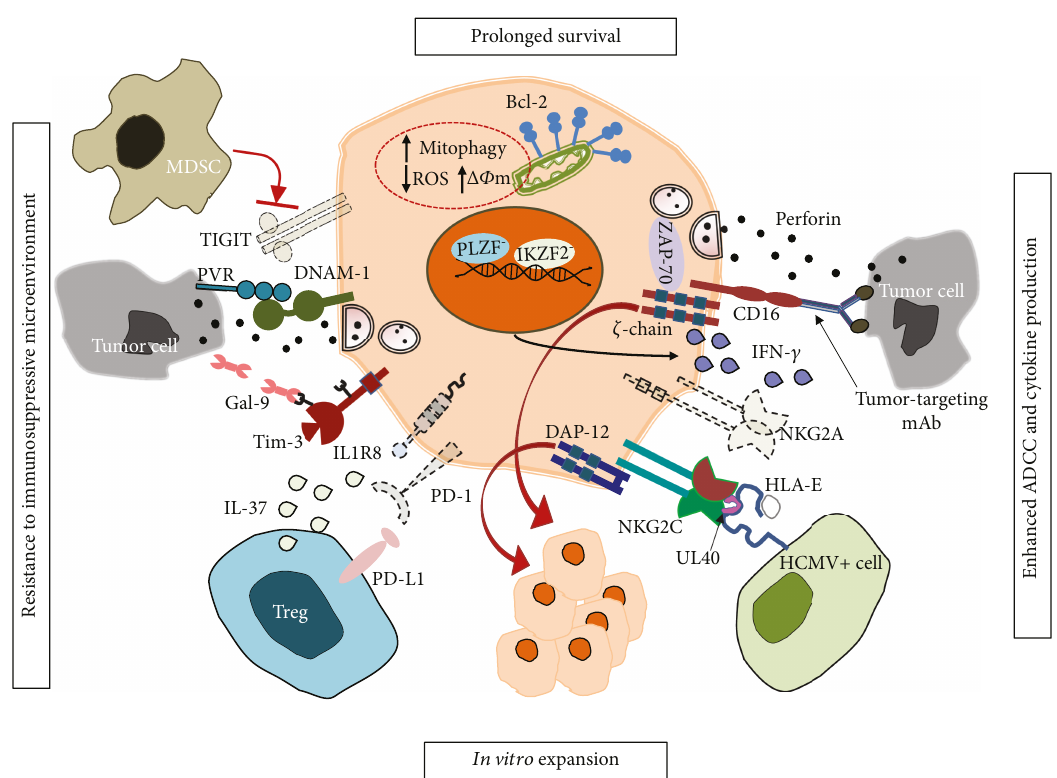
In vitro Figure 1: NKG2C + memory NK cell features exploitable in cancer immunotherapy. The dotted lines indicate reduced receptor